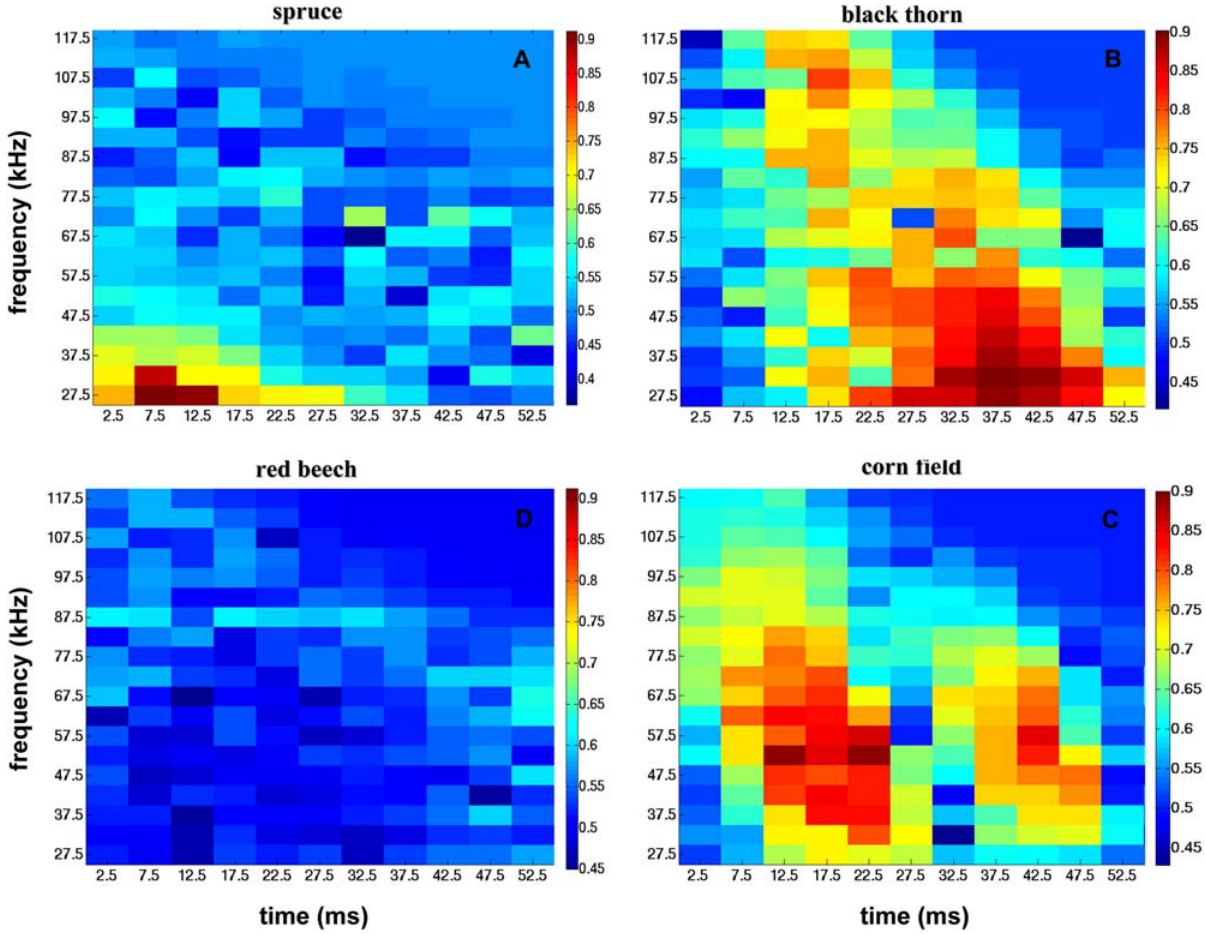
Figure 5. Classification performance of four classification tasks when using partial data of the spectrograms for classification. Each pixel represents the performance when using a square from the spectrogram with a frequency band of 5 kHz and time duration of 5 ms. The color denotes the area under the ROC curve (AUC) when classifying using only this square of information from the spectrograms. The classification tasks presented are: (A) Spruce vs. the rest; (B) Blackthorn vs. the rest; (C) Beech vs. the rest; (D) Corn field vs. the rest.